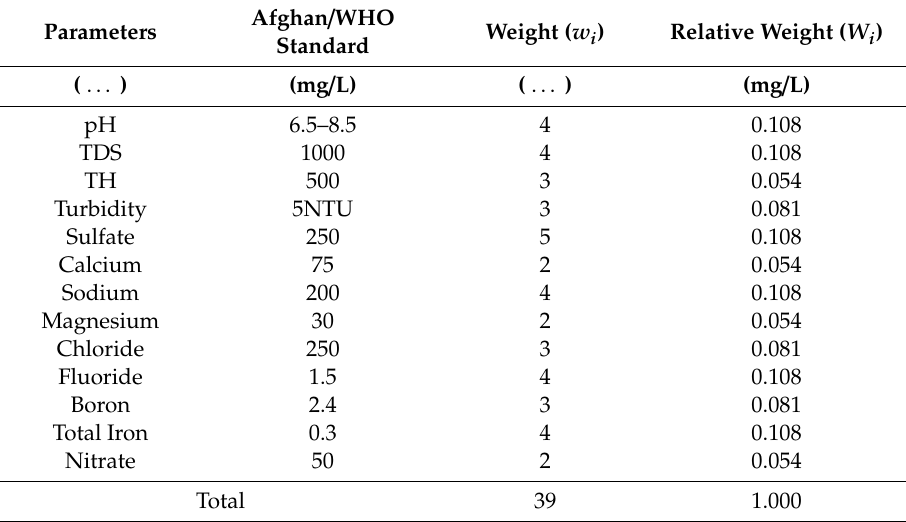
Table 3. Calculation of relative weights of physicochemical parameters based on [23]. Afghan / Parameters